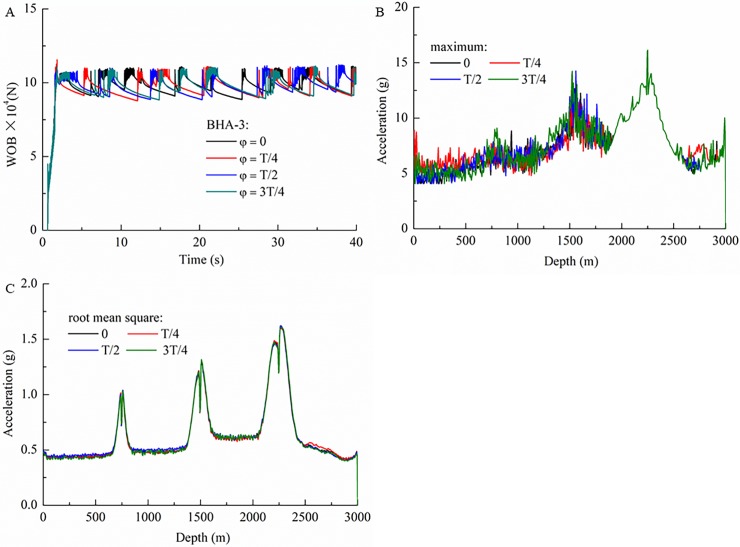
Effect of phase difference of shakers on WOB and accelerations.(A) Change in weight on bit in the bottom hole with time. (B) Maximum acceleration along the drill-string. (C) Root mean square acceleration along the drill-string. https://dx.doi.org/10.17504/protocols.io.kfbctin.